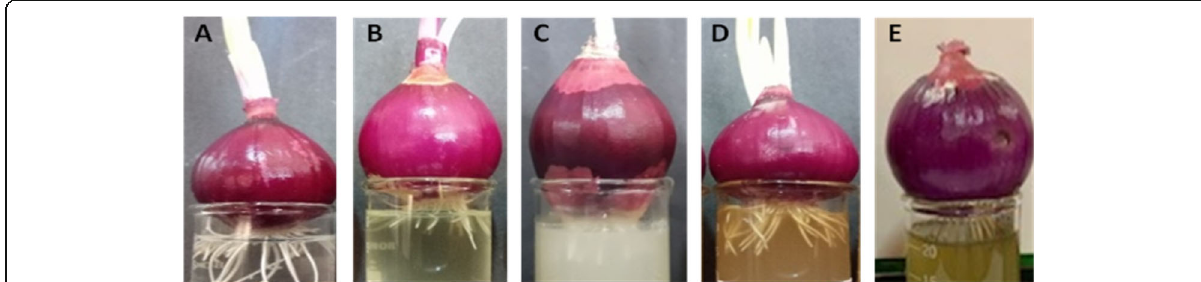
Fig. 1 Allium cepa experiment: treatment of Allium cepa root with a water (control), b methotrexate (standard), c M. pruriens extract, d A. longifolia and e S.